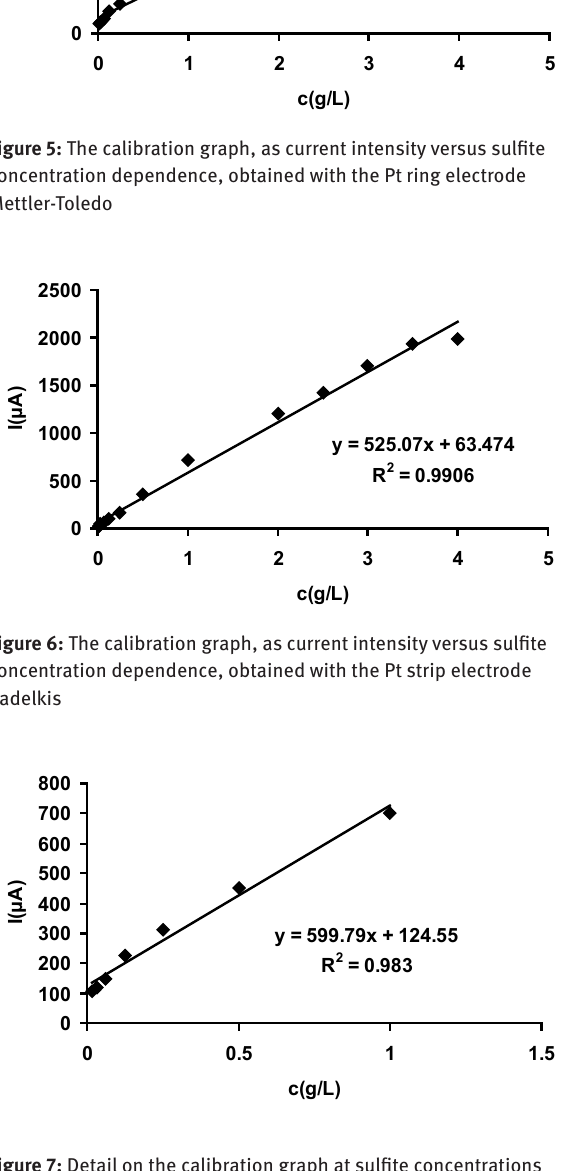
The equations of the calibration graphs below 1 g L -1